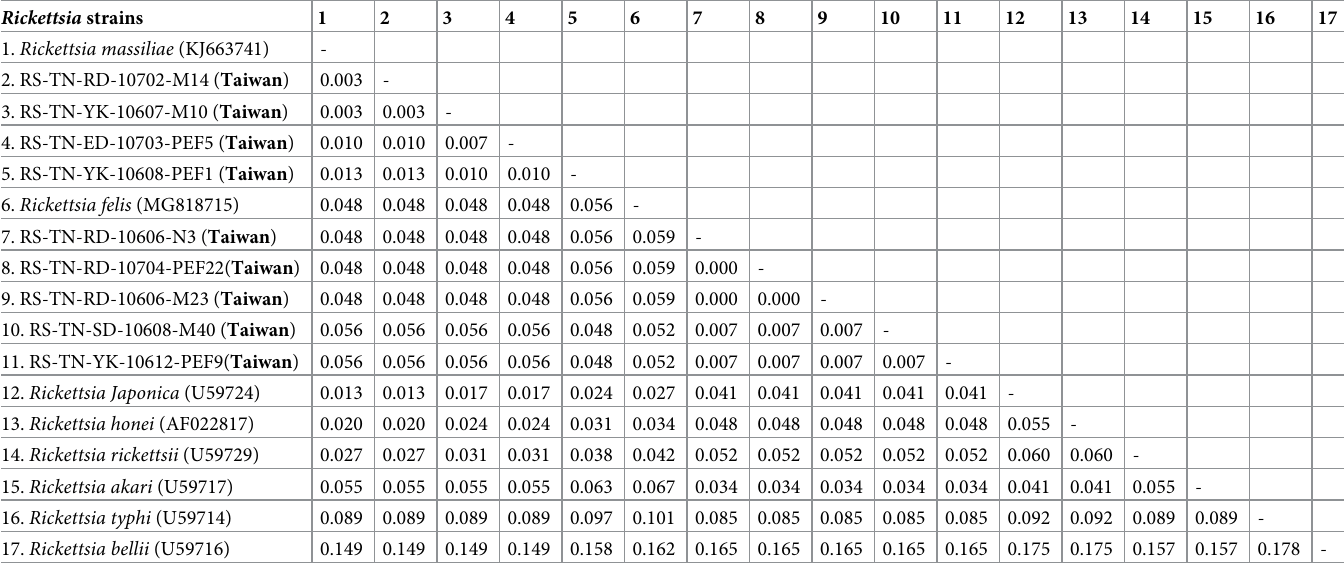
Table 2. Intra- and Inter-species analysis of genetic distance values a based on the gltA gene sequences among various Rickettsia strains. Rickettsia strains